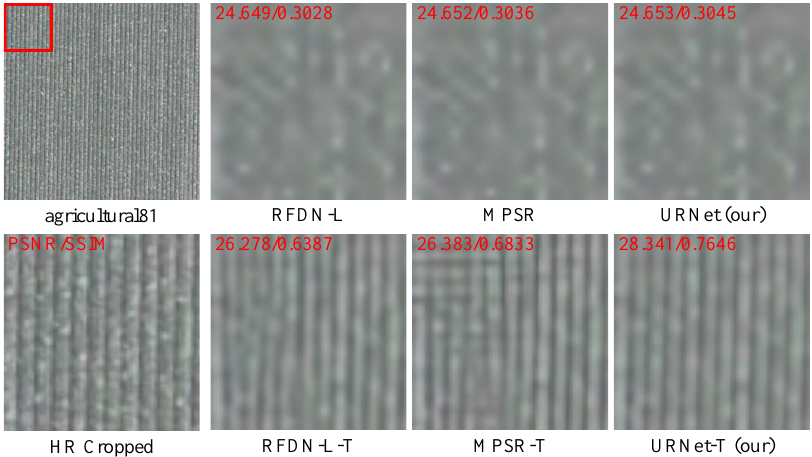
Figure 10. Comparison of reconstructed HR images of “agricultural81” obtained from UCTest dataset with 256 × 256 pixel images using different methods with a scale factor of × 4.